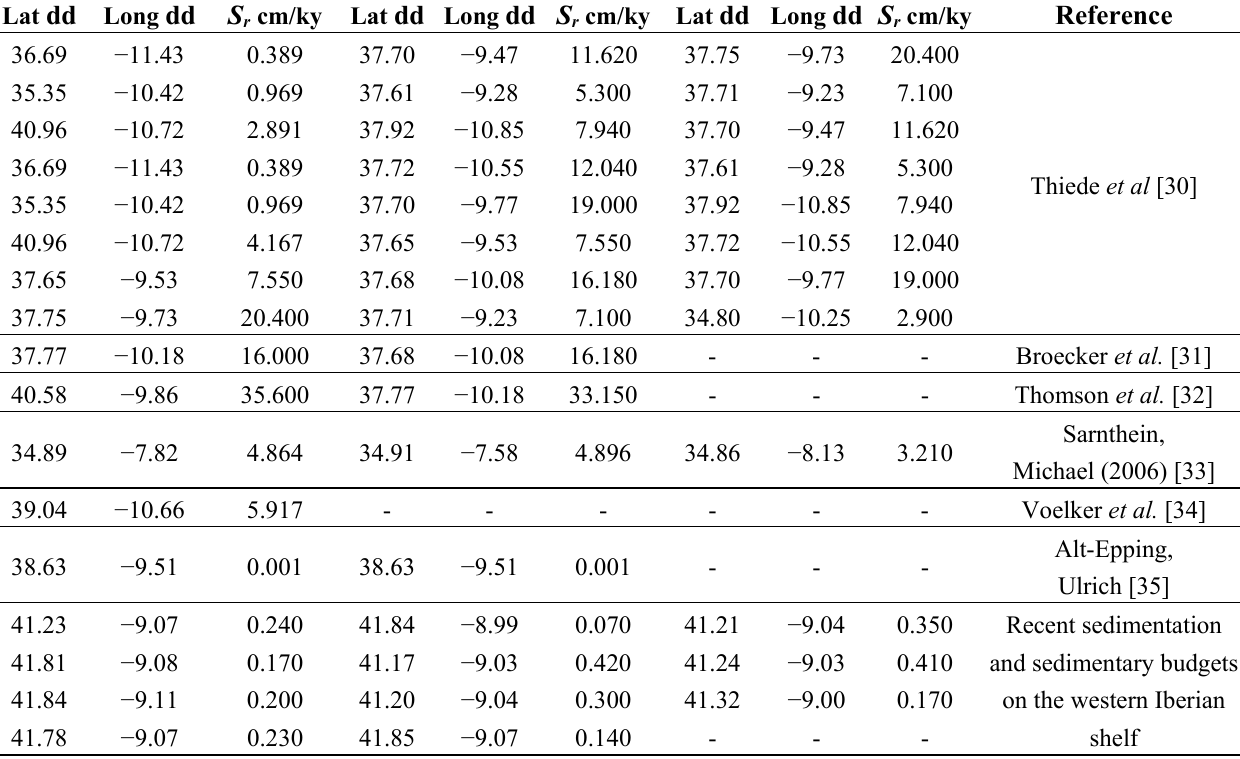
Table 1. Sedimentation rate data and source. Pangea website